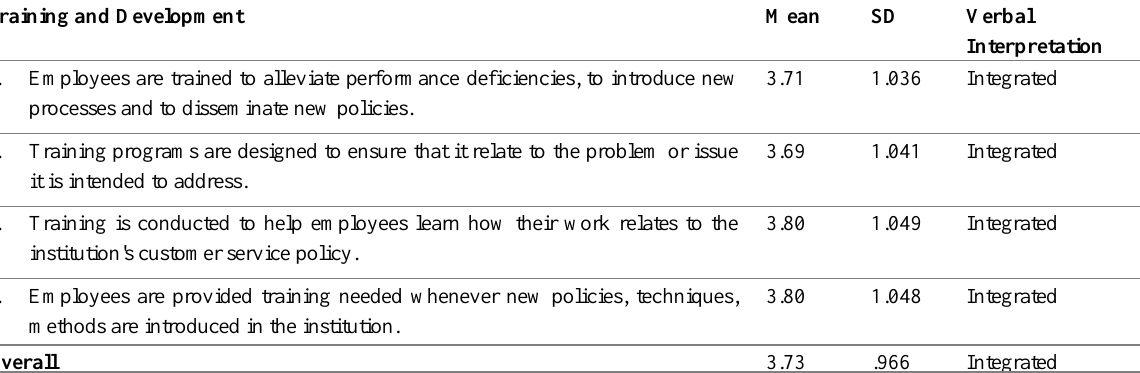
Training and Development Mean SD Verbal